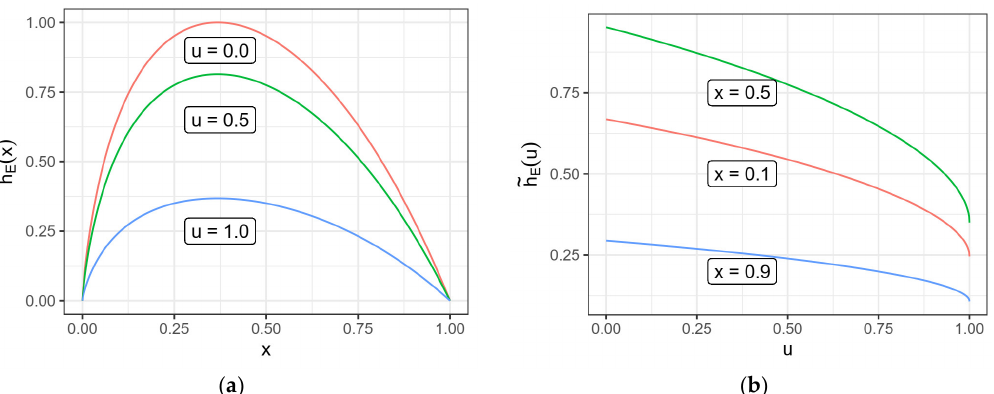
Figure 3. Hesitant fuzzy sets. ( a ) Hesitant membership degrees for ℎ () . ( b ) Hesitant member- ship degrees for ℎ () .